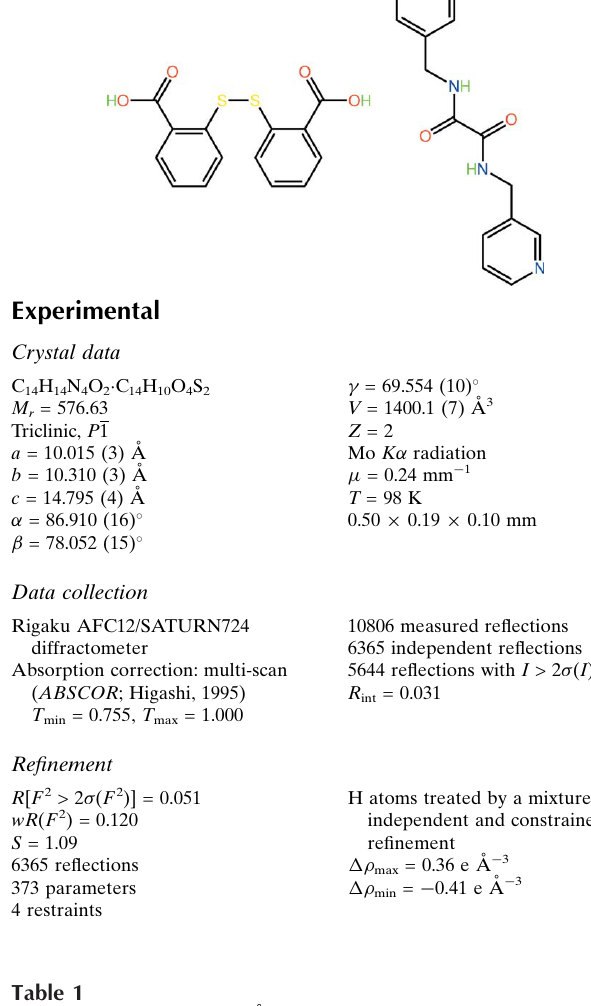
molecules. The Hydrogen-bond geometry (A˚ , (cid:3) ). D —H (cid:2)(cid:2)(cid:2) A D —H